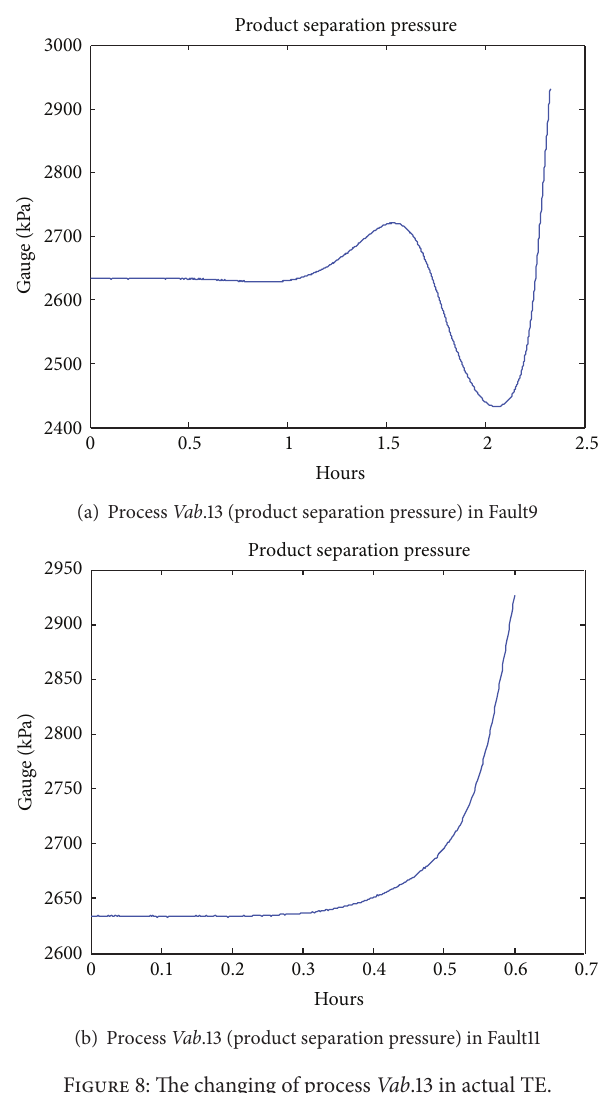
Figure 8: The changing of process Vab .13 in actual TE.